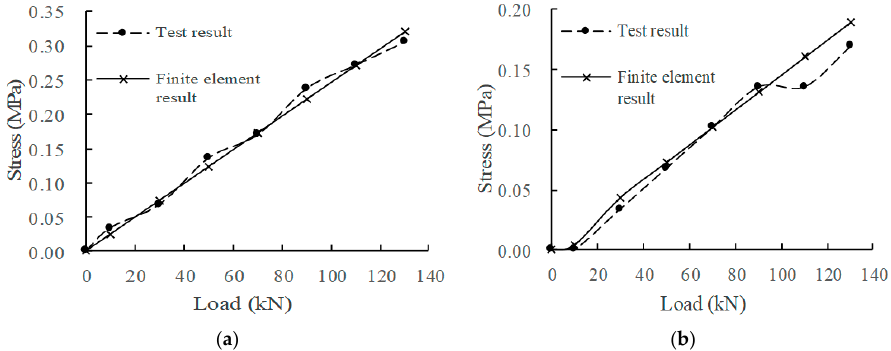
Figure 10. Track slab stress: ( a ) 0 million times of train load; ( b ) 30 million times of train load.